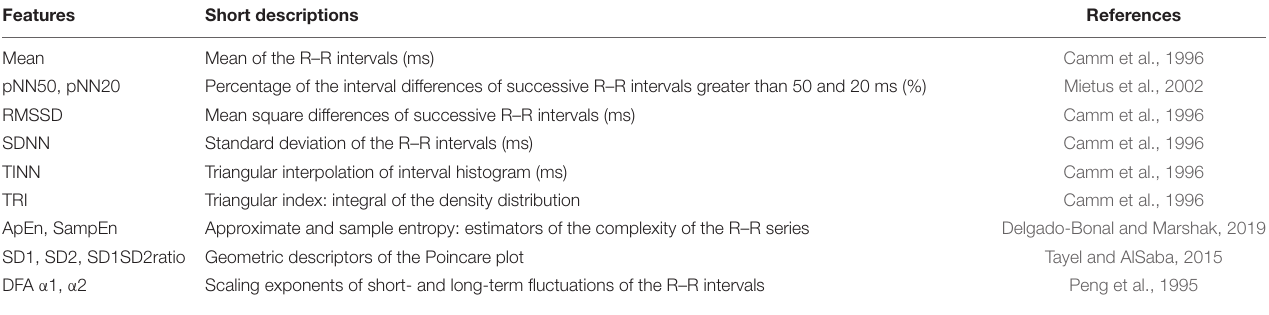
TABLE 1 | Description of the heart rate variability features used in the analysis.